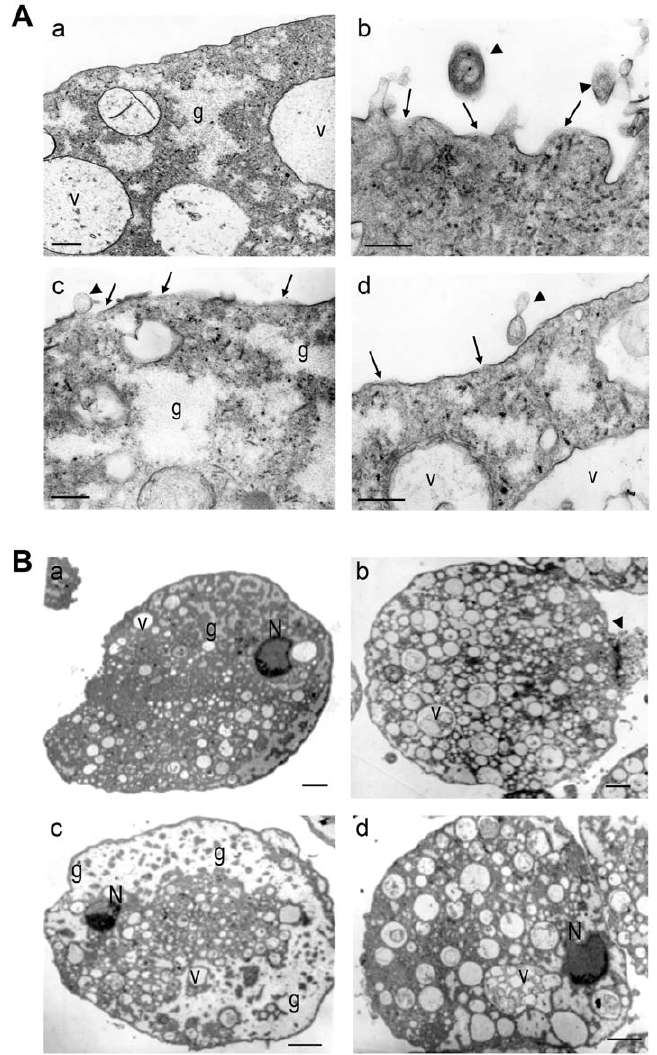
Figure 4. Ultrastructural alterations of trophozoites assessed by transmission electron microscopy. In panels A and B, E. histolytica trophozoites were incubated in: CM of CaCo2 cells not exposed to the pathogens (a); CM from cells exposed to PFA-fixed trophozoites (b); CM from cells exposed to ETEC (c) or incubated with 10 ng/ml of CECE-HBD2 (d) and then prepared for transmission electron microscopy. Panel Aa, a control trophozoite showing continuous plasma membrane without alterations (arrows), small clear zones in the cytoplasm in which glycogen localizes (g) and clear vacuoles (v). Panel Ab shows a trophozoite incubated in CM from CaCo2 cells exposed to trophozoites with many alterations in the cytoplasm, ruptured zones in the plasma membrane and extruded cellular material and a great increase in the number of vacuoles containing cellular material (v). Panel Ac shows a representative trophozoite exposed to CM from ETEC-exposed cells with discontinuities in the membrane and ruptures (arrows), increased content of glycogen (g) and increased number of vacuoles, many containing cellular material (v). Arrowheads point to extracellular material. Panel Ad, a trophozoite treated with CECE-HBD2 shows alterations of the membranes similar to those observed in trophozoites incubated in CM from pathogen-exposed cells. Bar=0.5 m m. B. Low magnification of representative trophozoites treated as indicated in each of the panels above, shows control trophozoites with regular distribution of the chromatin (N), tethered to the nuclear membrane. Trophozoites treated with CM of pathogen-exposed cells or CECE-HBD2 show chromatin aggregated and polarized (N) and a high number of big vacuoles containing cellular material (v). Bar=3.0 m m.